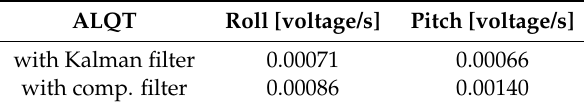
Table 4. Average battery consumption by ˆ u ∗ ϕ .